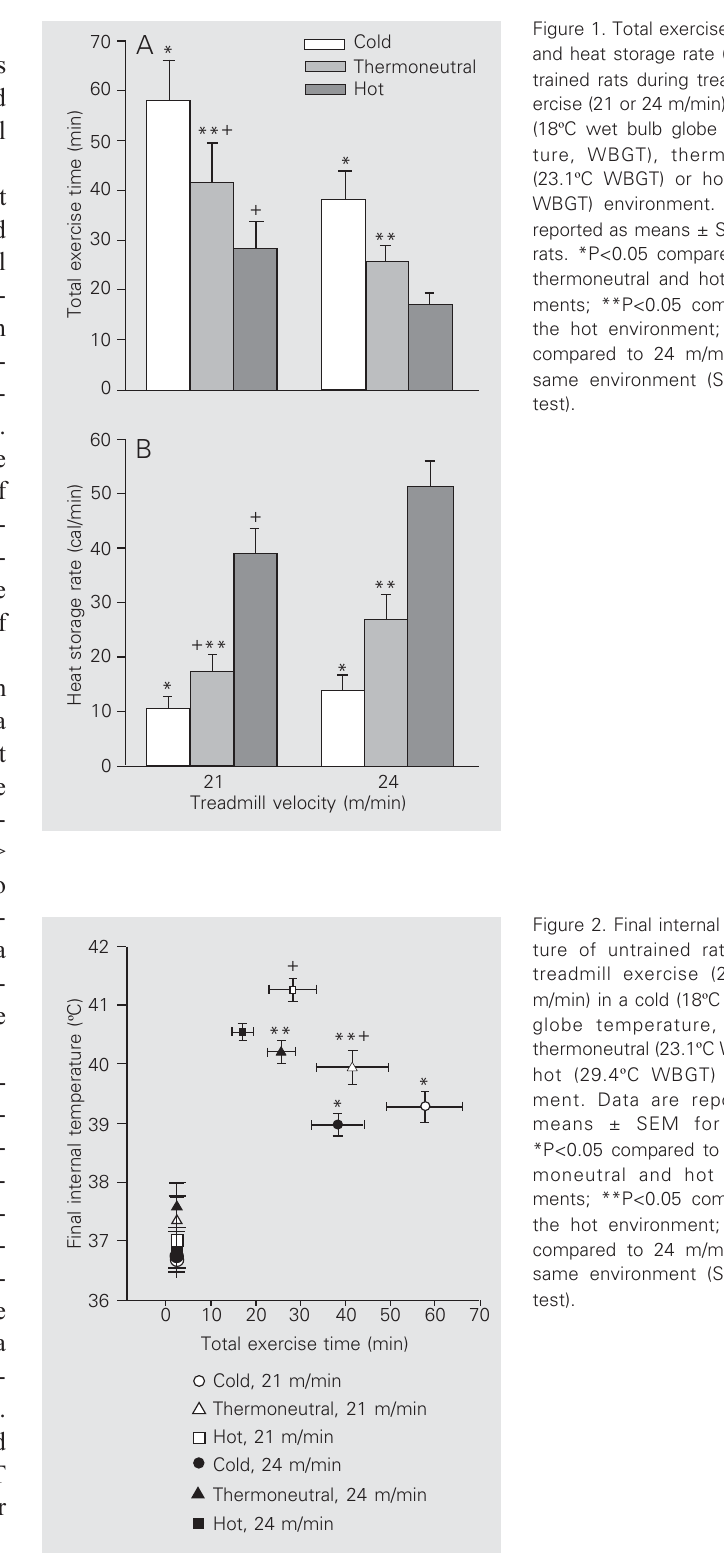
Figure 1. Total exercise time (A) and heat storage rate (B) of un- trained rats during treadmill ex- ercise (21 or 24 m/min) in a cold (18 (cid:1) C wet bulb globe tempera- ture, WBGT), thermoneutral (23.1 (cid:1) C WBGT) or hot (29.4 (cid:1) C WBGT) environment. Data are reported as means ± SEM for 6 rats. *P<0.05 compared to the thermoneutral and hot environ- ments; **P<0.05 compared to the hot environment; + P<0.05 compared to 24 m/min in the same environment (Student t- test).